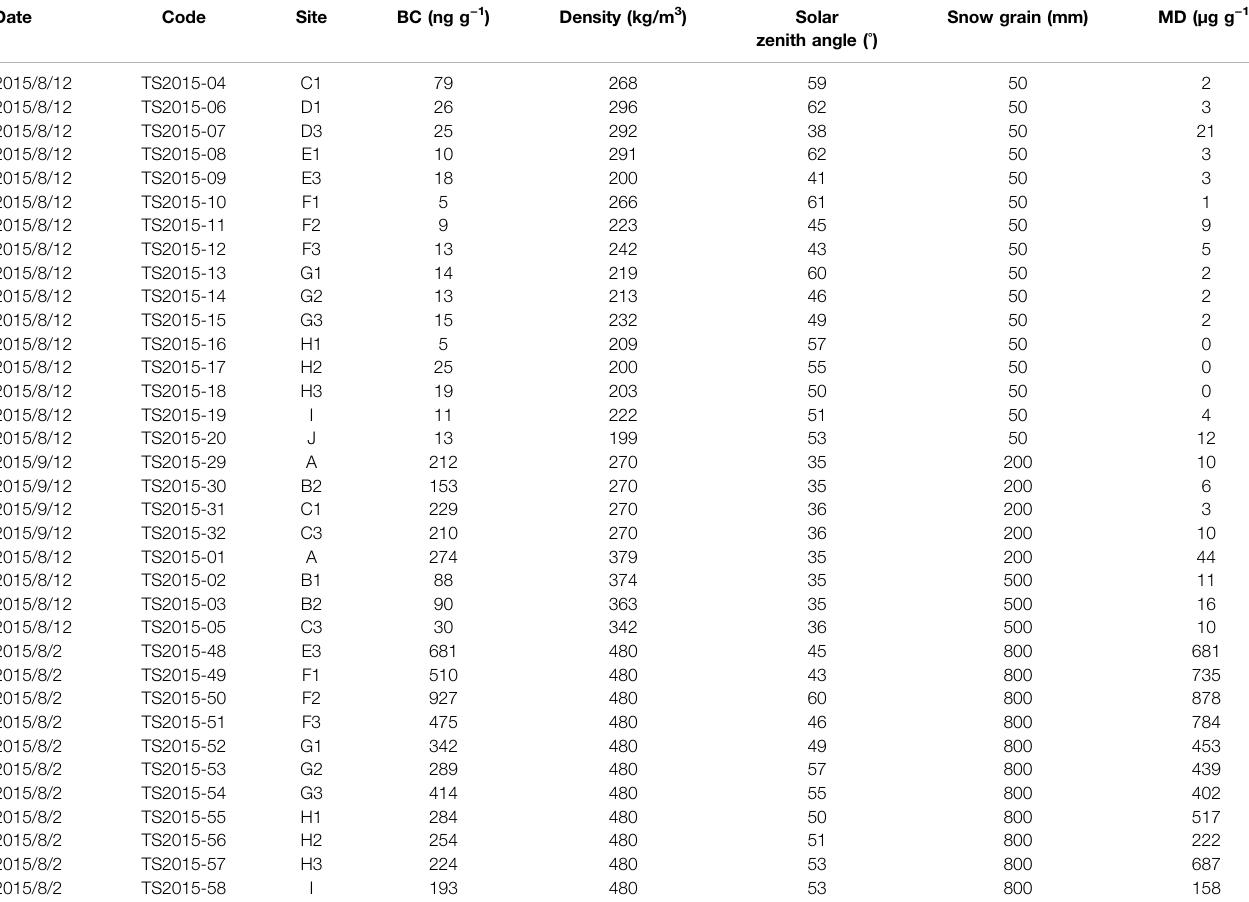
TABLE 1 | Input parameter of the SNICAR